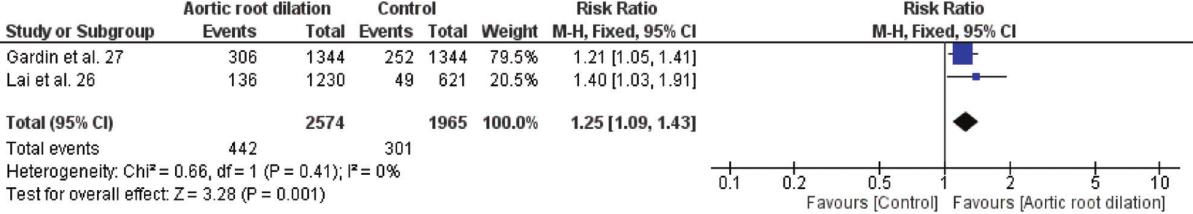
Figure 3.4 - The Risk Ratio and 95% confidence interval (CI) in the cardiovascular events (non-fatal), for aortic root dilation group versus the Control